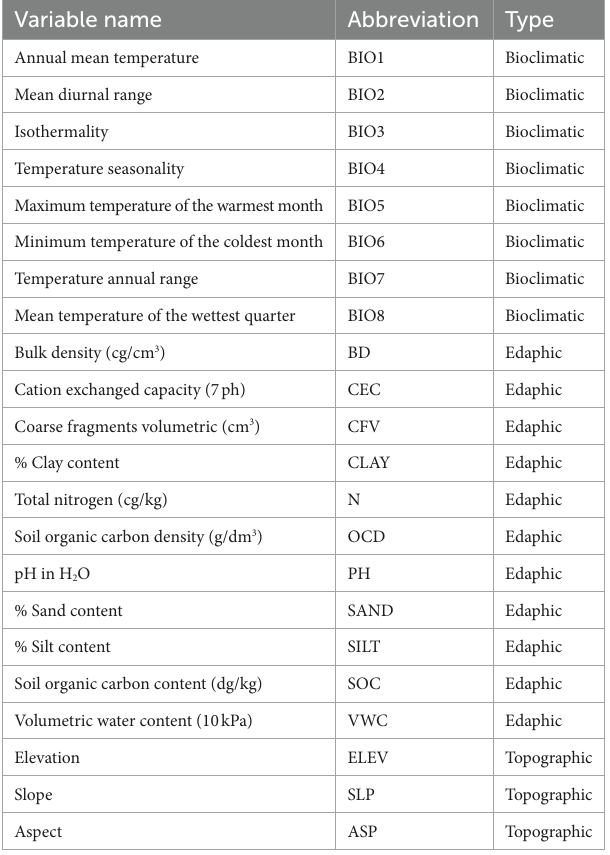
TABLE 2 Name and assigned abbreviation for the 22 predictor variables used in this